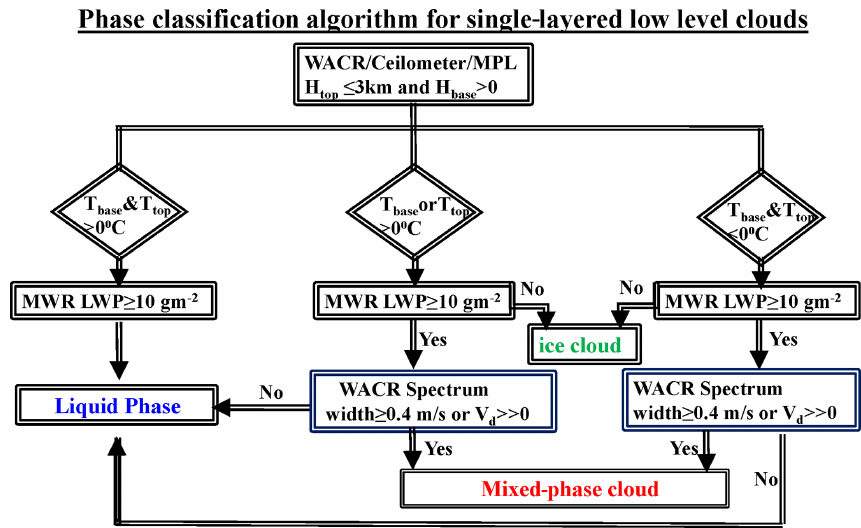
Figure 5. A flow chart for phase classification of single-layered, low-level clouds. W-band (95GHz) ARM Cloud Radar (WACR) provides radar spectrum width (WID) and Doppler velocity ( V d ).